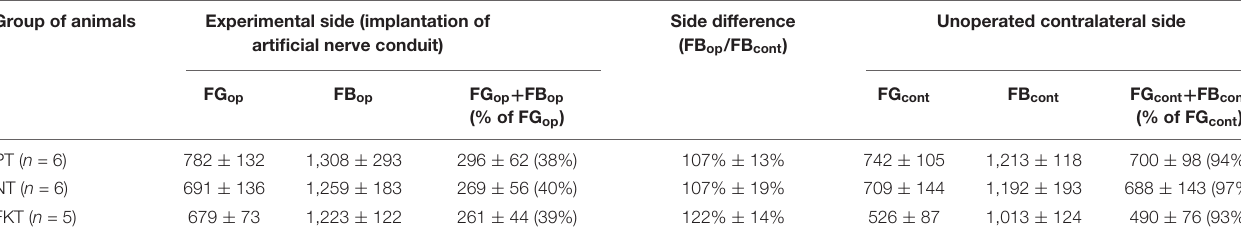
TABLE 2 | Systemic drug treatment by nimodipine or FK506 (Tacrolimus) after implantation of an artificial nerve conduit for nerve repair. Group of